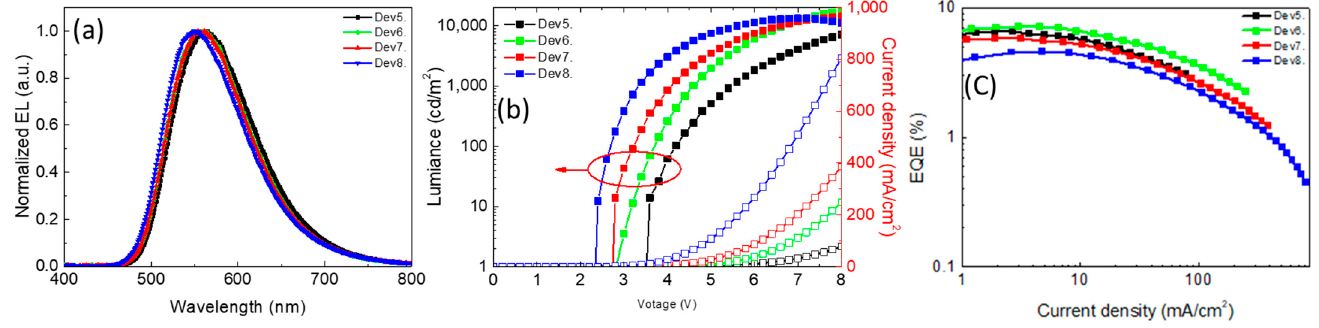
Figure 6. ( a ) Electroluminescence spectra, ( b ) EQE versus current density characteristics, and ( c ) current density–voltage– luminance curves of TAPC:PO-T2T devices with different thicknesses. Table 4. Properties of OLED devices for device structure: ITO, PEDOT:PSS (40 nm), TAPC:PO-T2T (2:1) with different thicknesses, POT2T (60 nm), LiF (1 nm), and Al (100 nm). Thickness Device